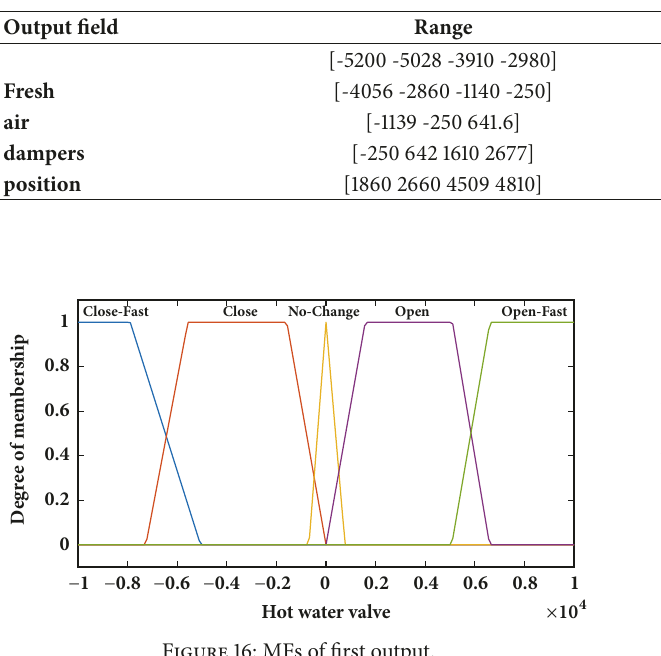
Table 10: MFs of third output.